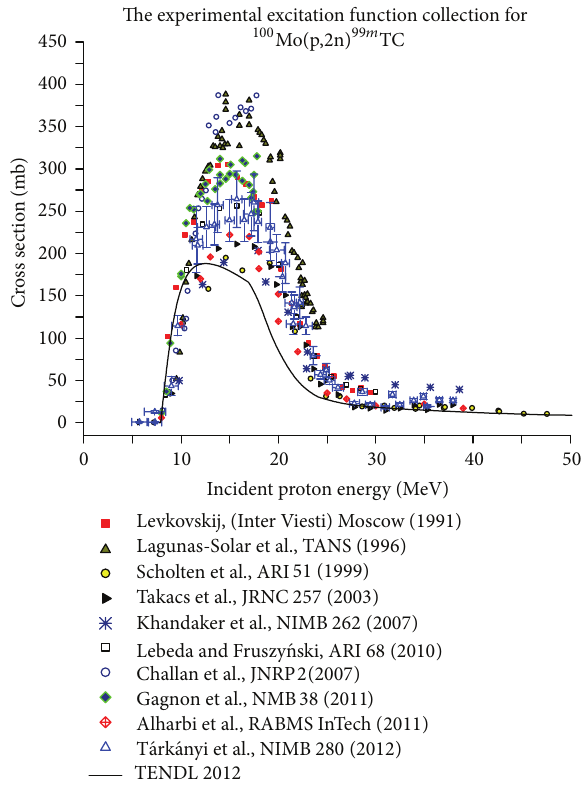
Figure 4: The collection of 100 Mo(p,2n) 99𝑚 Tc excitation functions experimentally measured in the last two decades. Error bars are shown for the most recent measurement only performed by T´ark´anyi (2012) [13]. The most recent theoretical excitation function by the TENDL 2012 library is also shown [24].